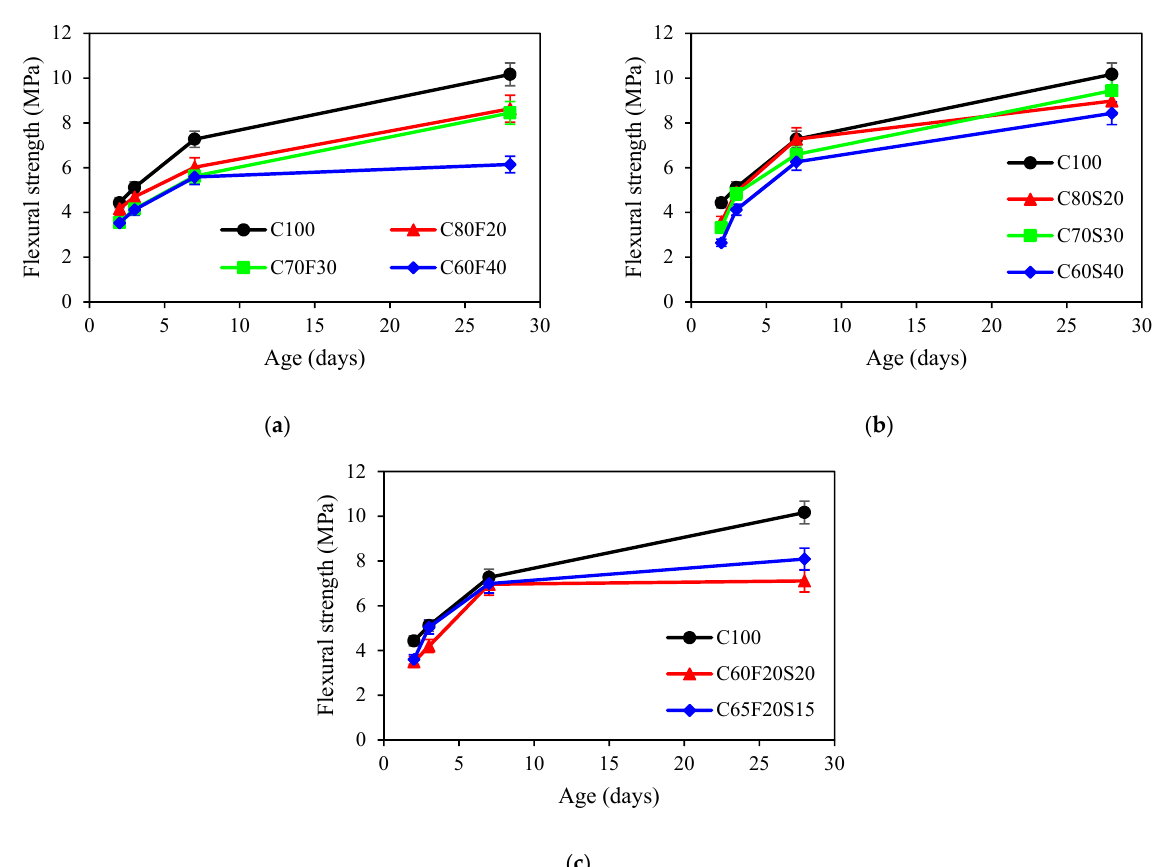
Figure 6. Flexural strength of concrete: ( a ) fly ash group; ( b ) GGBFS group; ( c ) ternary binder group. Table 3. Elastic modulus of concrete